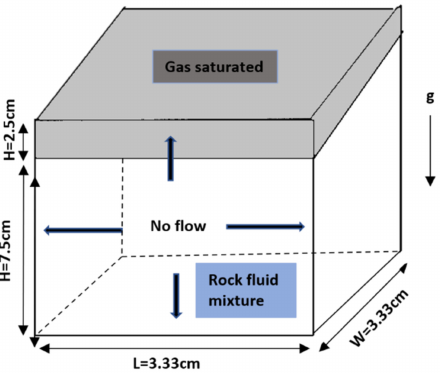
Figure 4. Conceptual model representation, including the initial and boundary